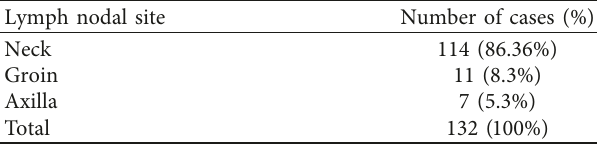
Table 1: Distribution of the lymph nodal biopsy site ( n � 132 ) .